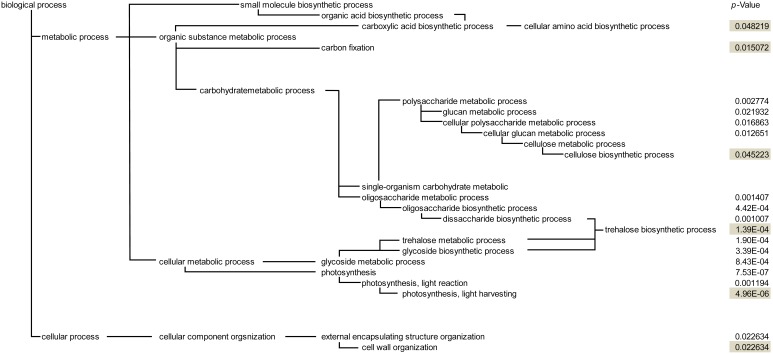
Significantly enriched categories were identified using QuickGO.In response to additional fertilization, 1,365 genes were up- or down-regulated; FDR-corrected P-values of categories at the deepest hierarchical level are shaded; *P<0.05.